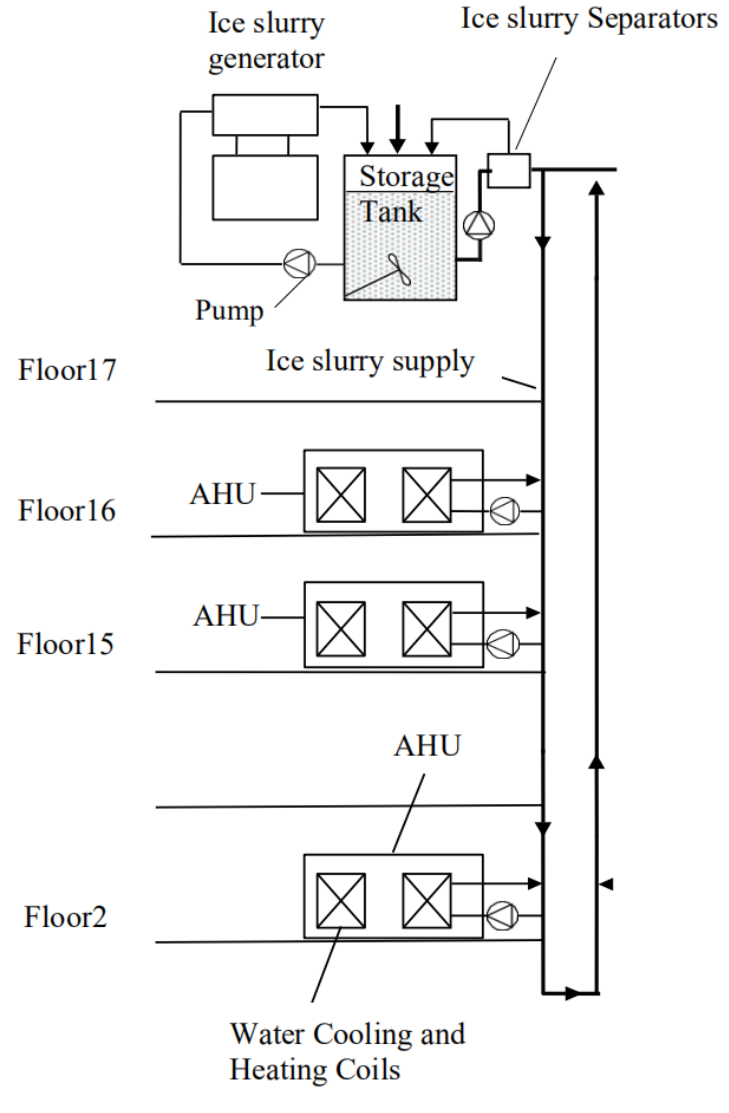
Figure 1. Schematic diagram of the ice slurry cooling system in the CAPCOM building.